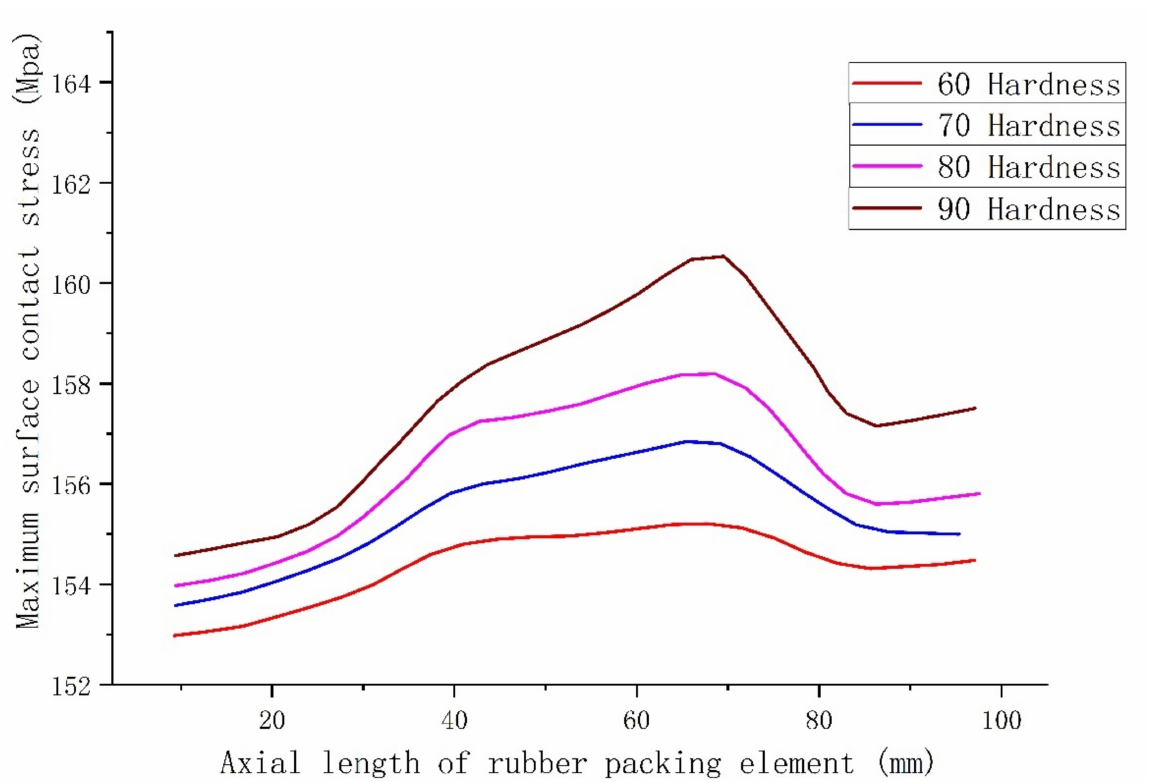
Figure 12. Relationship of length to maximum contact stress of the rubber packing element at different hardness